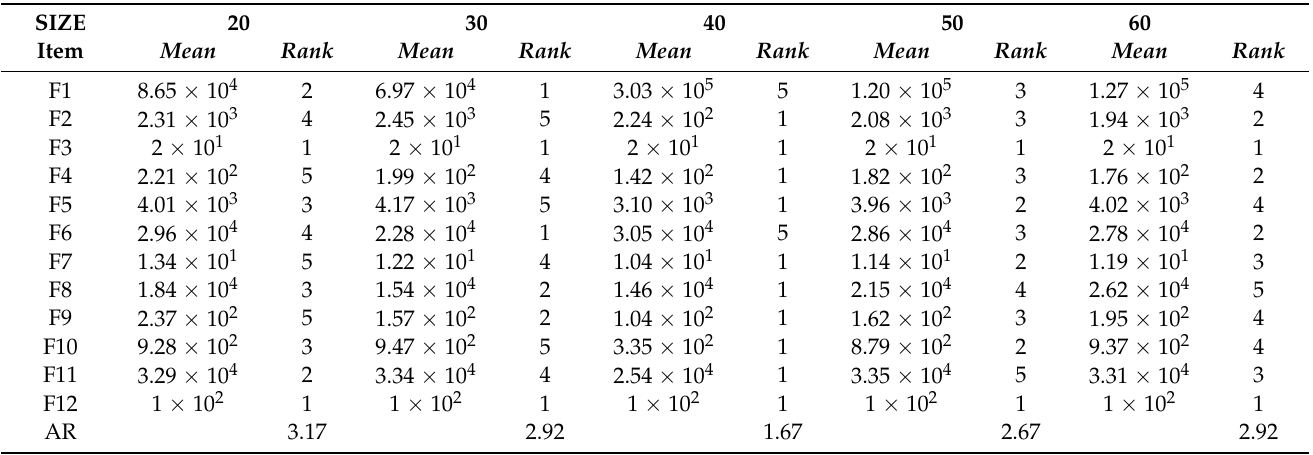
Table 4. Sensitivity analysis for N s .